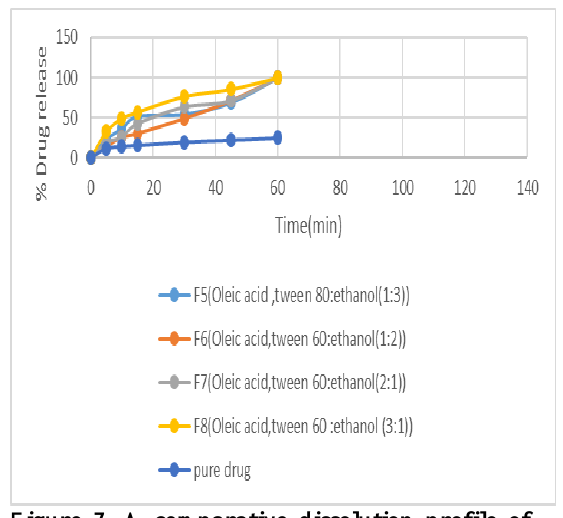
Figure 6. A comparative dissolution profile of felodipine nanoemulsions (F1, F2,F3,F4 and pure felodipine) in 500ml of 0.1 N HCl (containing 1% tween 80) dissolution medium at 37°C.